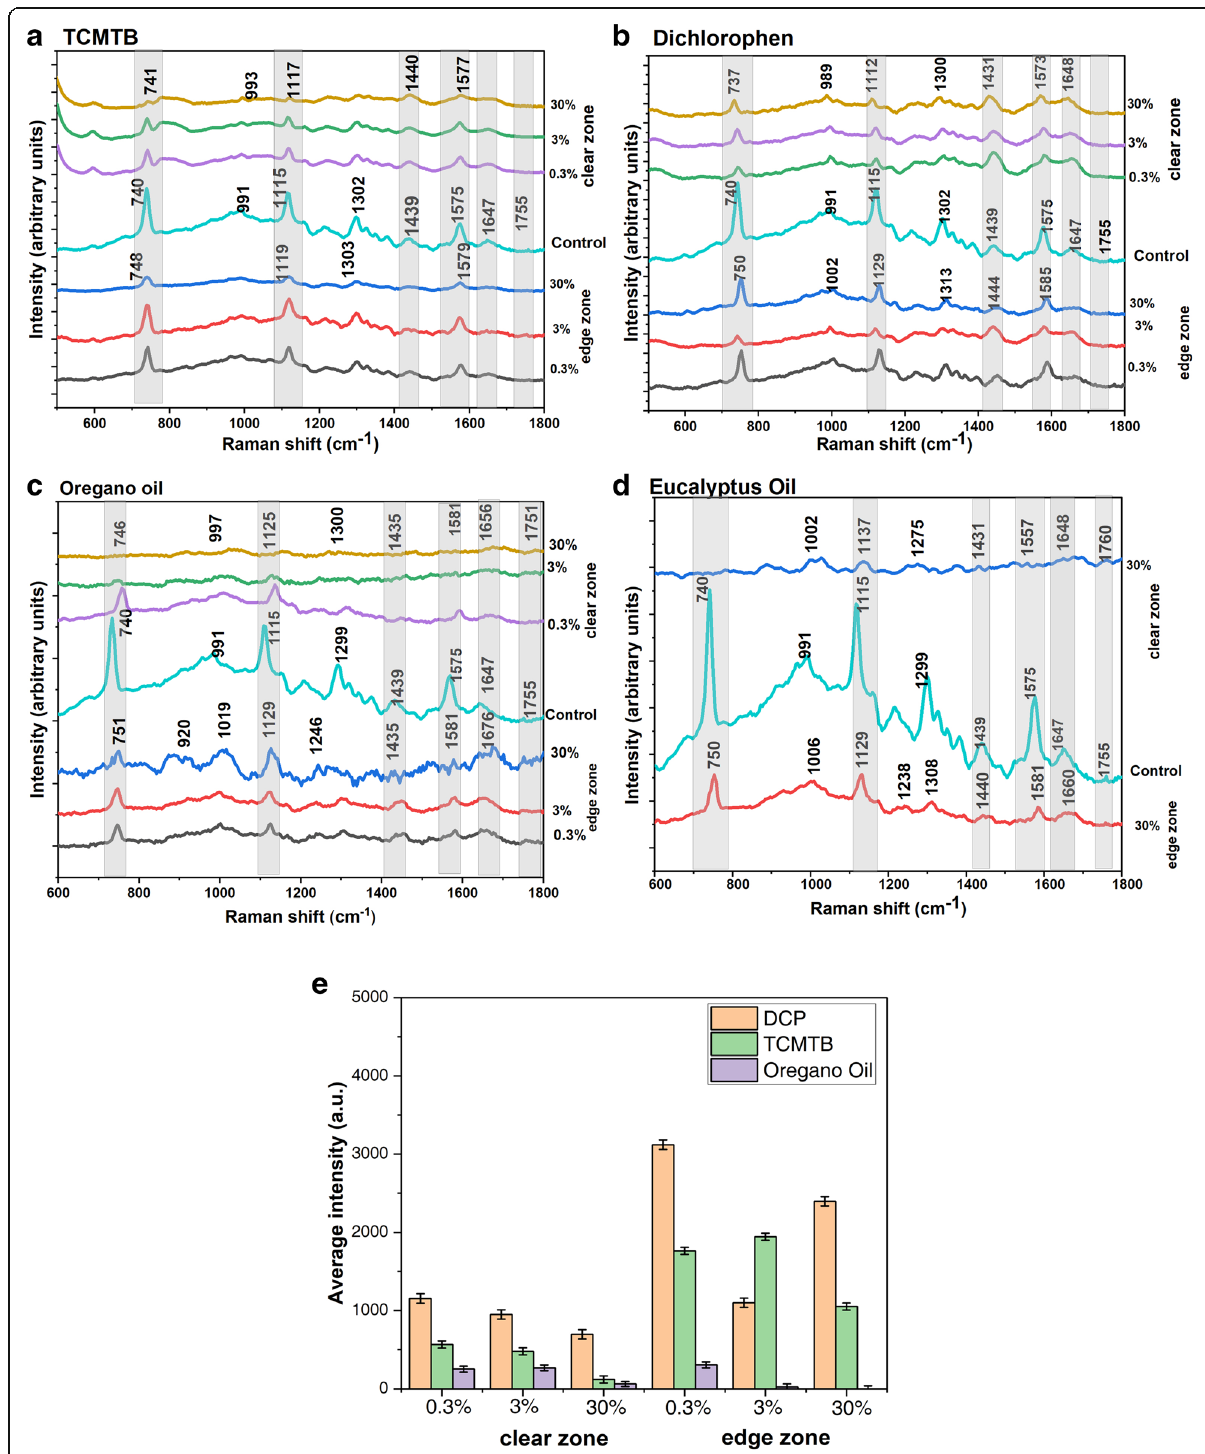
Fig. 3 Average Raman spectra from clear and outer edge zone of A. hydrophila grown in the presence of various concentrations of a TCMTB b DCP (dichlorophen) c oregano and d eucalyptus oil e average intensity trend of strong Raman peak at ~ 740 cm − 1 of cytochrome protein as an indicator of bacterial cell lysis. Spectra were offset for